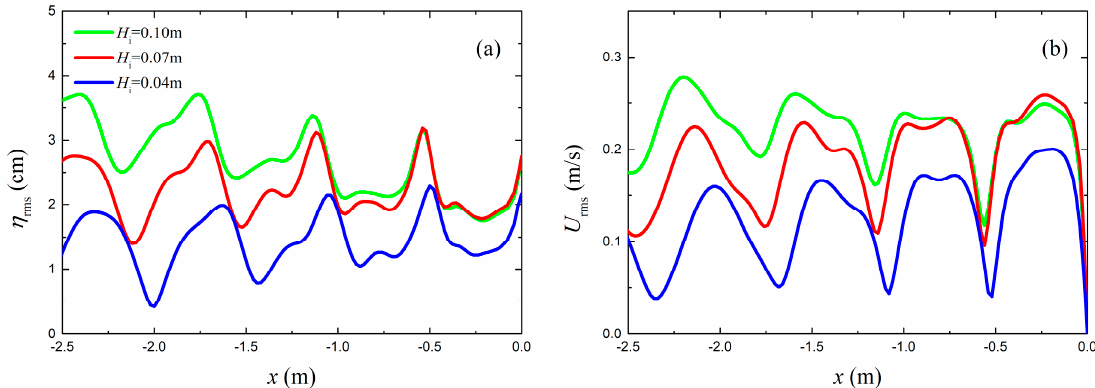
Figure 10. Computed spatial distributions of ( a ) η rms and ( b ) U rms near the seawall for Cases 1–3.